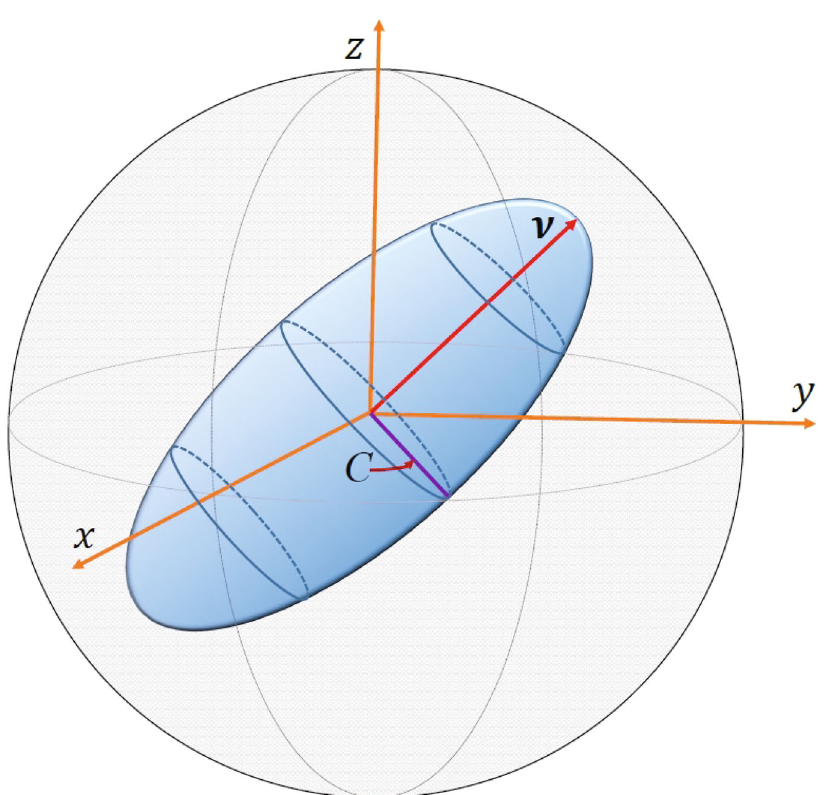
Fig. 1 Geometric illustration of the XYZ protocol in the Bloch sphere. For a given concurrence C , the guessing probability is maximized when the semi-major axis v of the correlation ellipsoid parallels one of the eight intelligent